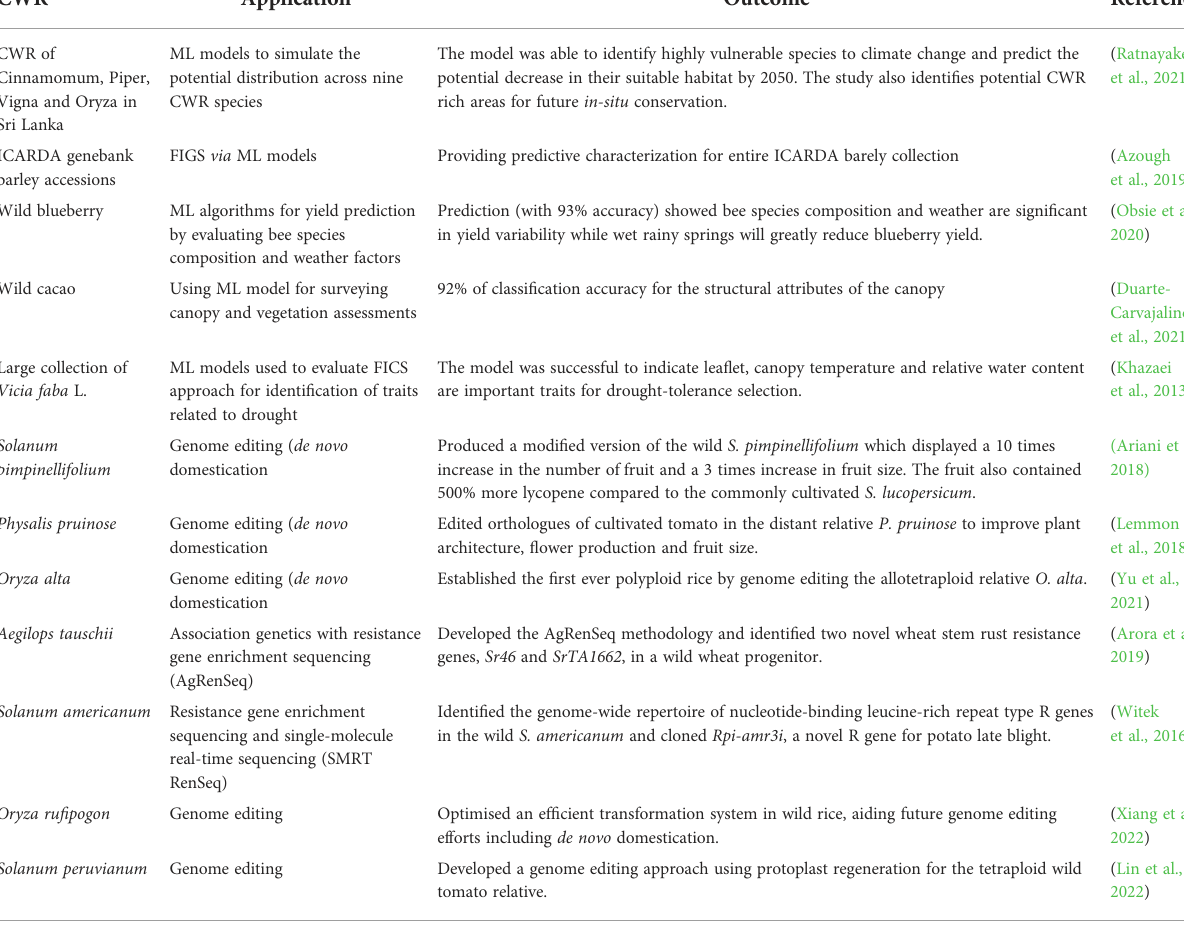
TABLE 3 Case studies of the most recent applications of CWRs for crop improvement.